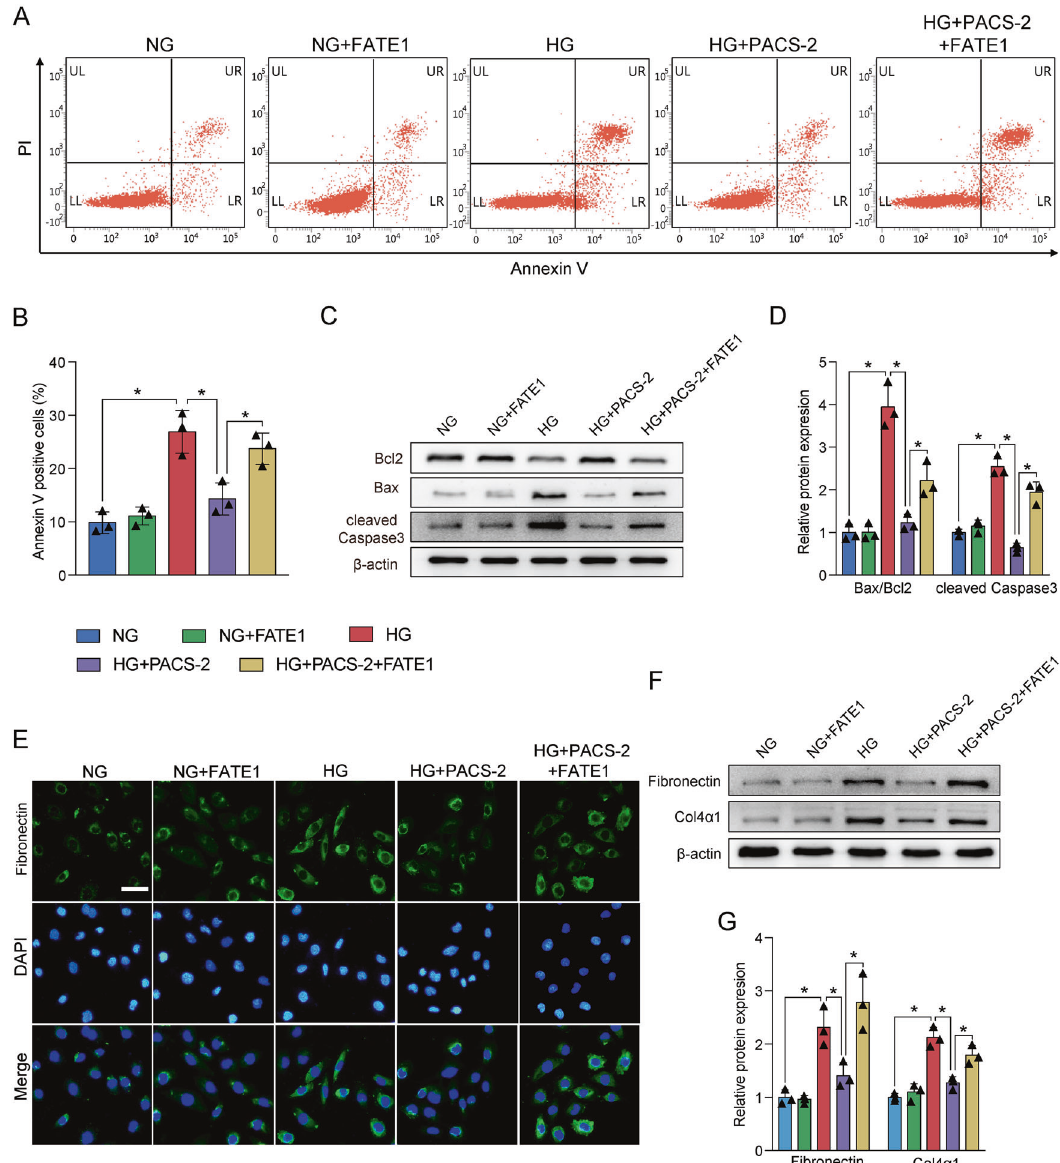
Fig. 8 MAM integrity was required for the suppression of HG-induced apoptosis and fi brosis. A Representative images of fl ow cytometry in HK-2 cells. B Quantitative analysis of percent of apoptotic cells in A . n = 3. C Western blot bands of Bax, Bcl2, and cleaved Caspase3 in HK-2 cells. D Quantitative analysis of indicated protein levels in A . n = 3. E Immuno fl uorescence staining of Fibronectin in HK-2 cells. Scale bar = 50 μ m. F Western blot bands of Fibronectin and Col4 α 1 in HK-2 cells. G Quantitative analysis of indicated protein levels in F . n = 3. All data are expressed as mean ± SD. * P <